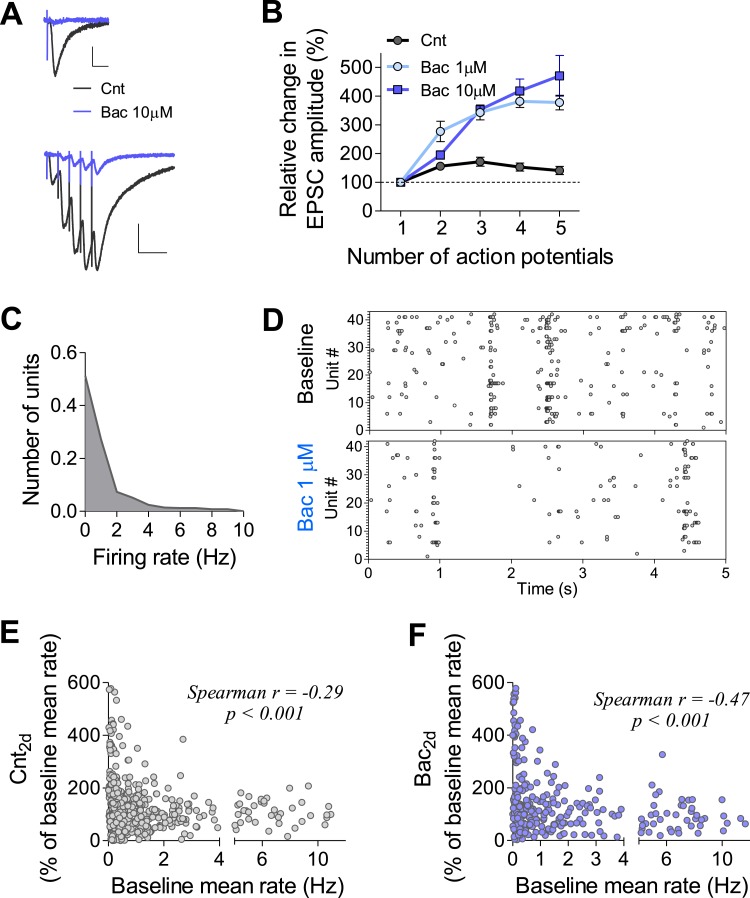
Properties of baclofen-induced changes in synaptic dynamics and single-unit firing in hippocampal neurons.(A) EPSC (−60 mV holding potential) traces evoked by low-frequency stimulation and by high-frequency spike bursts under control and 10 min after 10 µM baclofen application in acute hippocampal slices. Scale bars: Top: 20 pA, 20 ms; Bottom: 50 pA, 50 ms. (B) Baclofen increases short-term synaptic facilitation calculated based on EPSC measurements (1 µM—n = 5, p < 0.001; 10 µM—n = 4, p < 0.001) in acute hippocampal slices. (C) Distribution of per unit firing rate during 1 hr of control MEA recording (490 units). Firing rates are heavily skewed towards low frequencies. (D) Representative raster plots of MEA recording before and immediately after application of 1 µM baclofen. (E) Per unit correlation between baseline firing rates and the percent change in firing rates after 2 days of control recording showing significant negative correlation (Spearman r = −0.29, p < 0.001, 467 units). (F) Per unit correlation between baseline firing rates and the percent change in firing rates after 2 days in the presence of baclofen showing significant negative correlation (Spearman r = −0.47, p < 0.001, 311 units).